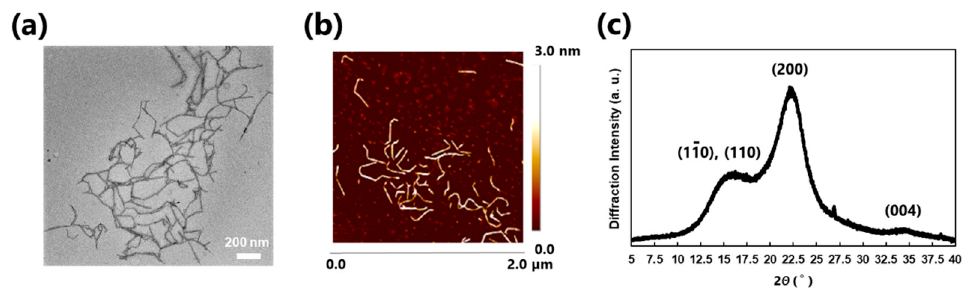
Figure 2. Characterization data of TOCNF used in this study. ( a ) transmission electron microscopy (TEM) image, ( b ) scan- ning probe microscopy (SPM) image (average height of each fiber = 2.1 ± 0.7 nm, n = 60 for each sample), and ( c ) X-ray diffraction (XRD) profile showing a typical cellulose I crystalline